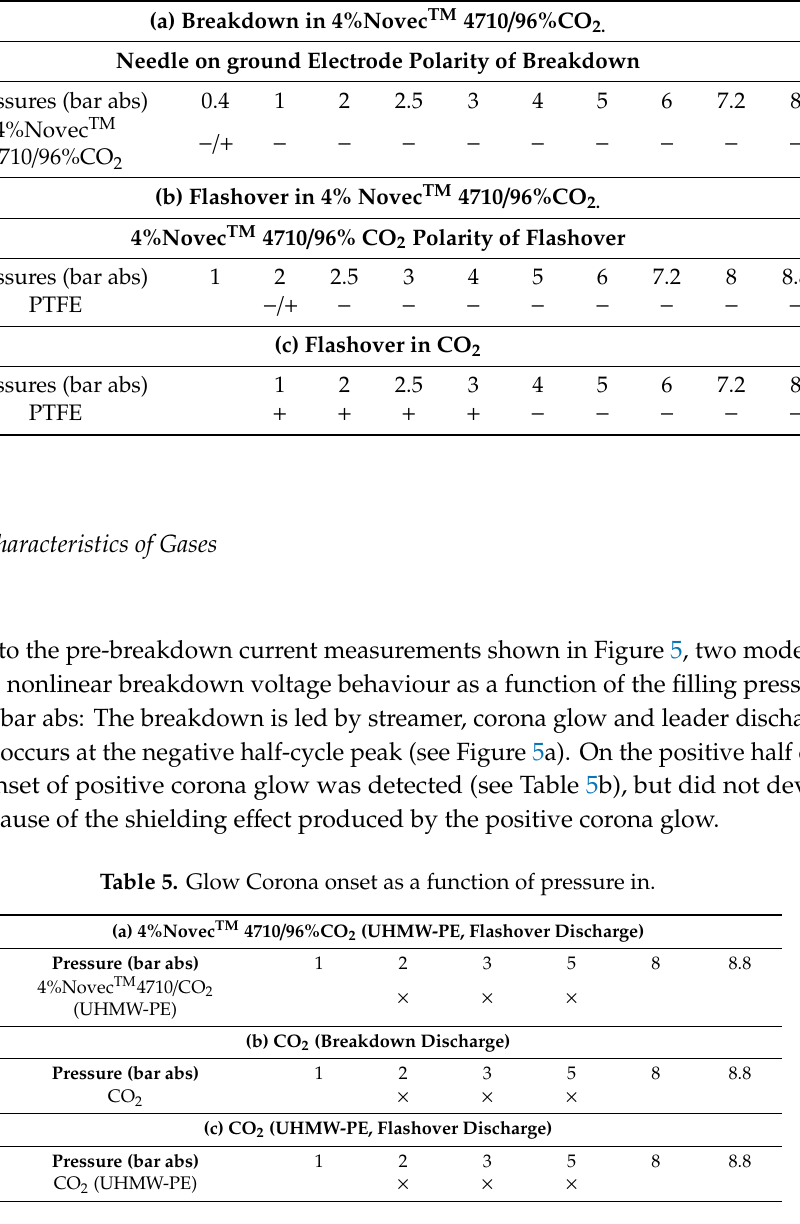
Table 4. AC polarity under di ff erent pressures up to 8.8 bar abs (Needle on Ground Electrode).